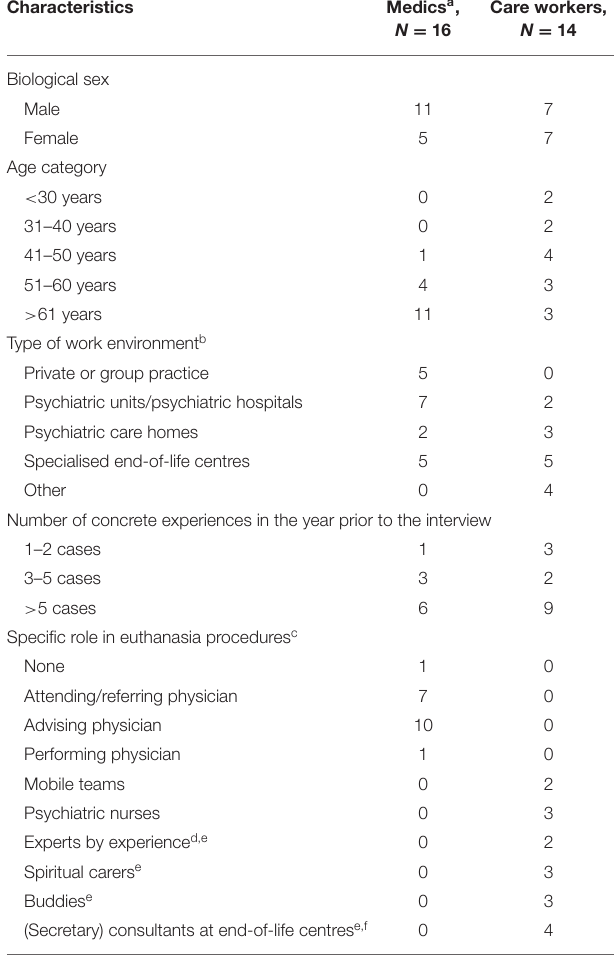
TABLE 1 | Healthcare Professionals and Volunteers’ characteristics ( N =